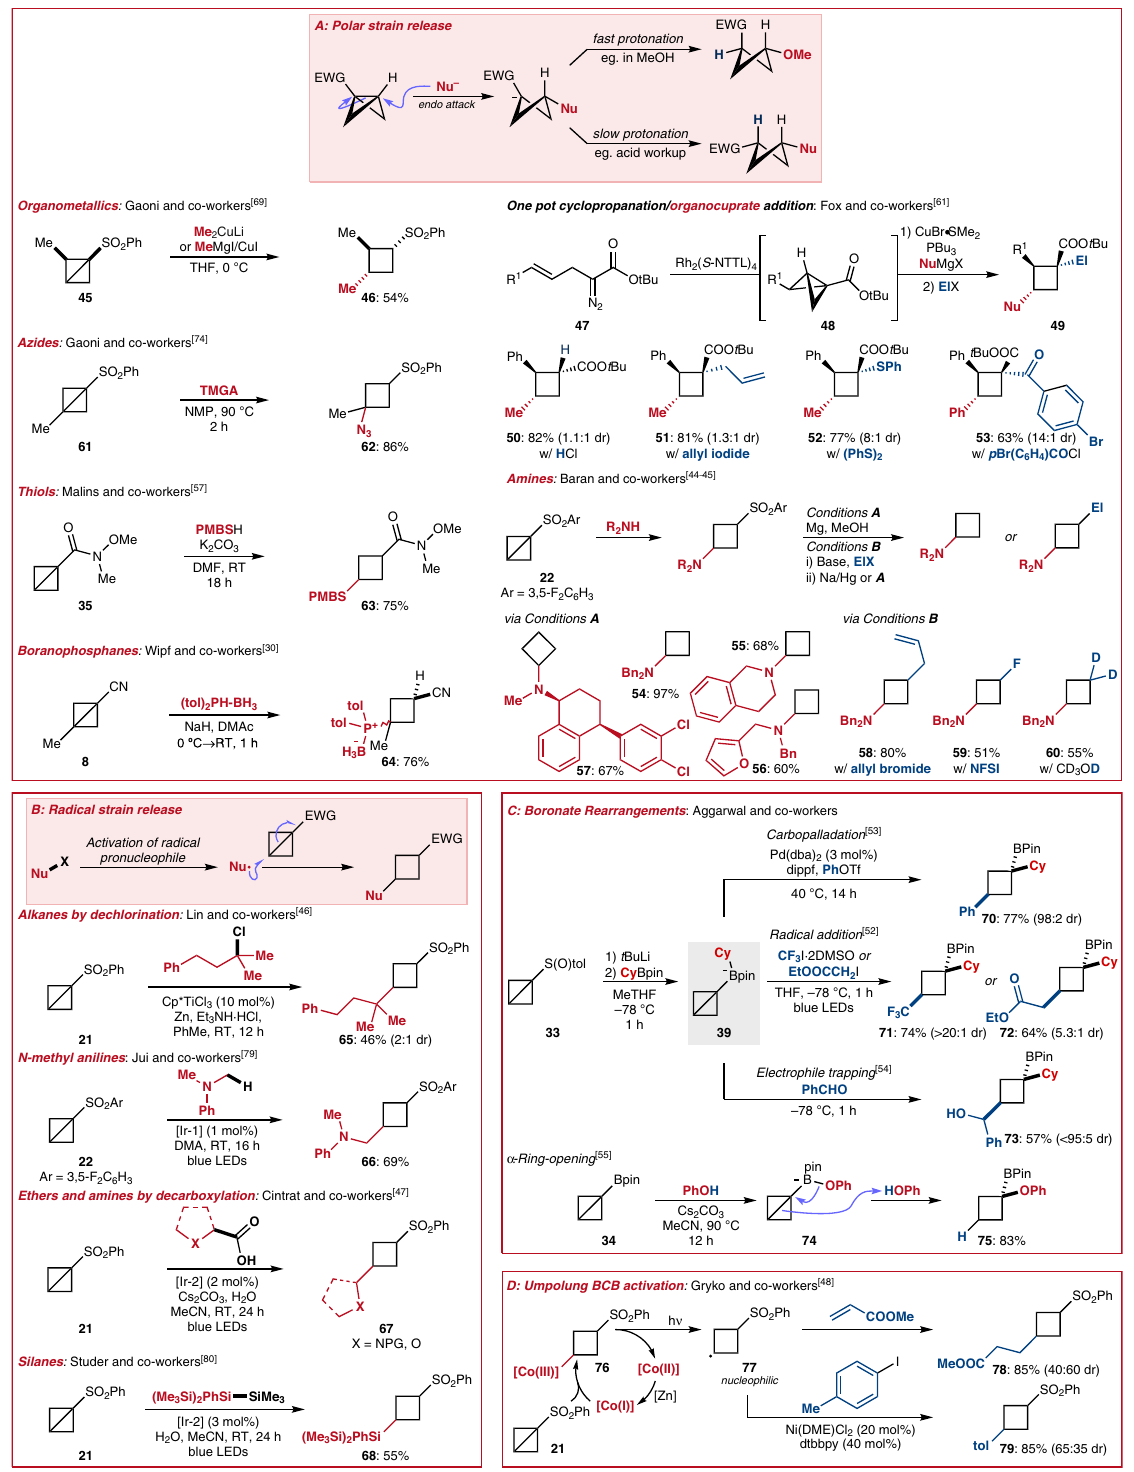
Fig. 3 Strain-release-driven ring-opening of BCBs to give substituted cyclobutanes. A Polar strain-release reactions with polar nucleophiles. B Radical strain-release reactions with radical nucleophiles. C Strain-release reactions driven by boronate rearrangement chemistry. Both polar and radical electrophiles can be used in these reactions. D Umpolung BCB activation with Co(I) complexes. Formal nucleophilic attack of the Co(I)-complex into the bicyclobutane gives a Co(III)-intermediate from which a cyclobutyl radical may be photochemically generated. Nu nucleophile, El electrophile, EWG electron-withdrawing group, TMGA tetramethylguanidinium azide, PMB para -methoxy benzyl, tol tolyl, NTTL N -1,8-naphthaloyl-( S )- tert -leucine, NFSI N - fl uorobenzenesulfonimide, [Ir-1] [Ir{dF(CF 3 )ppy} 2 (dtbbpy)]PF 6 , [Ir-2] [Ir(dF(CF 3 )ppy) 2 (5,5 ’ -d(CF 3 )bpy)]PF 6 , dba dibenzylideneacetone, dippf 1,1 ′ - bis(diisopropylphosphino)ferrocene, Tf tri fl uoromethylsulfonyl, pin pinacol, DME dimethoxyethane, dtbbpy 4,4 ′ -di-tert-butyl-2,2 ′ -dipyridyl; Cp* 1,2,3,4,5-